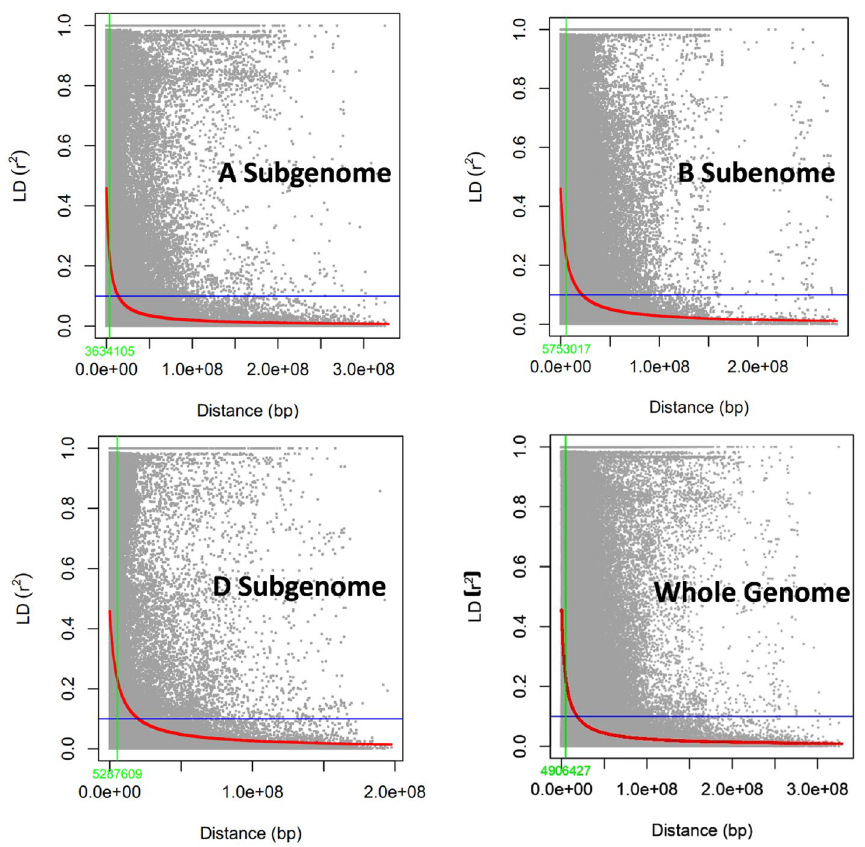
Figure 3. Subgenome and whole genome-wide linkage disequilibrium (LD) decay in GWAS panel of 280 diverse bread wheat genotypes.